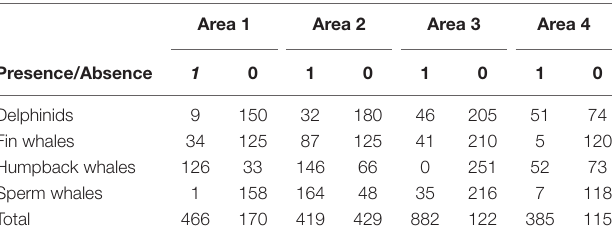
TABLE 1 | Number of files with species presence/absence (Presence: 1, Absence: 0) recorded between March 15 and April 26, 2018 per area surveyed on the shelf (Areas 1, 3, and 4) and shelf edge (Area